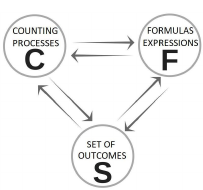
Figure 4. Model of students’ combinatorial thinking (adapted from